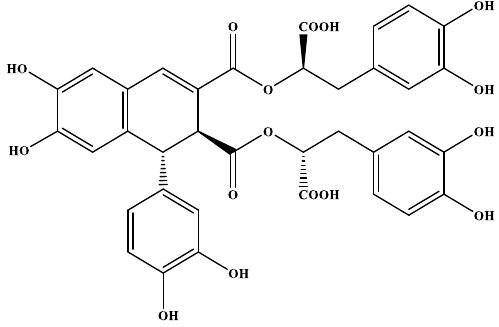
Figure 1. Chemical structures of (-)-rabdosiin ( 6 ) isolated from O. sanctum .